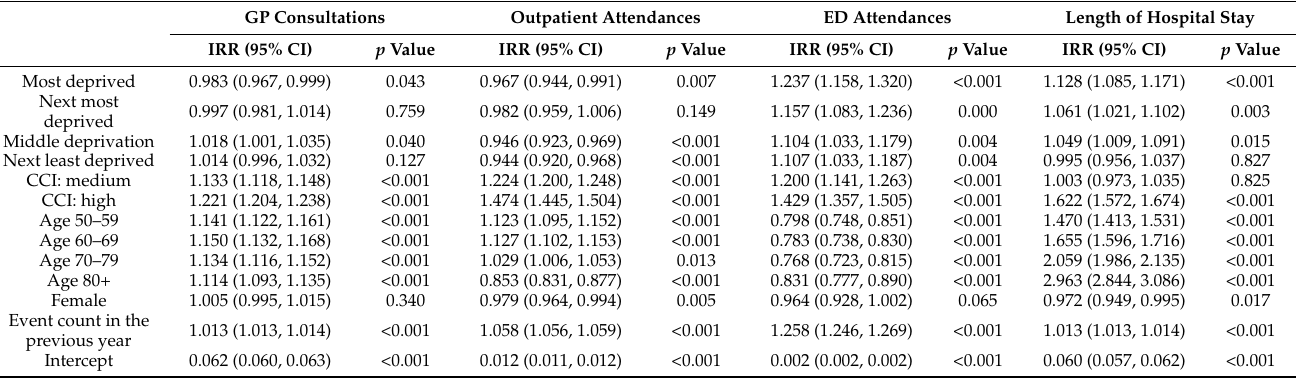
Table 2. Factors associated with 1-year post-critical-care HRU.